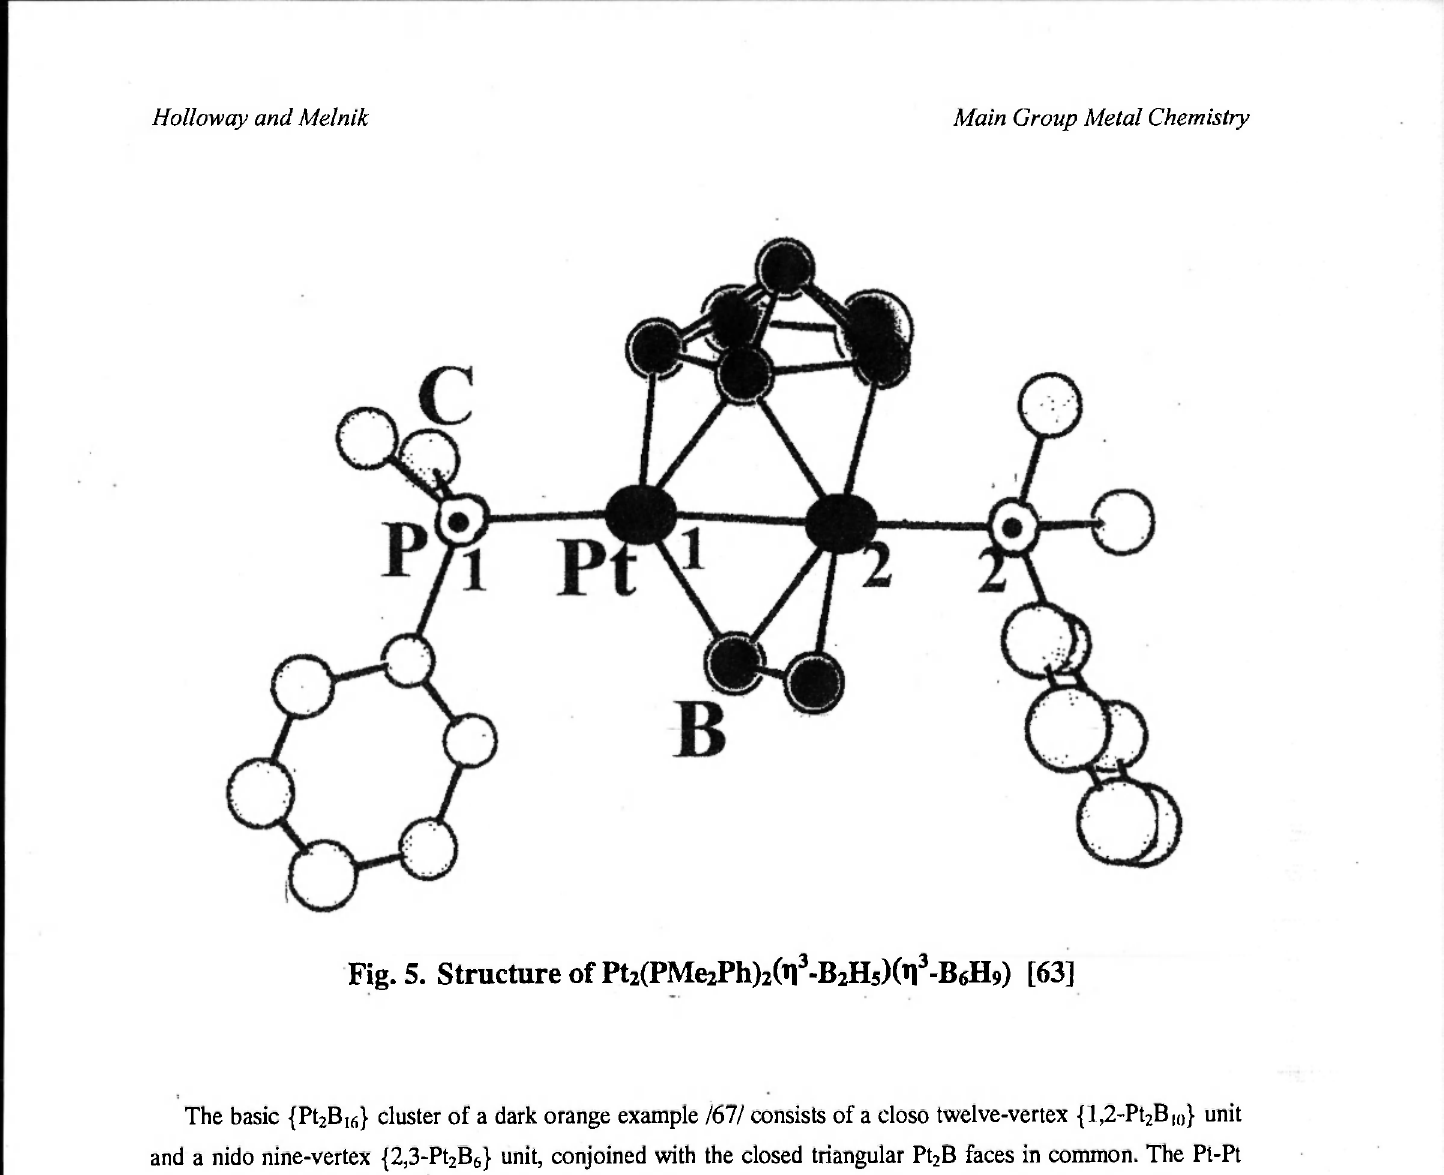
Fig. 5. S t r u c t u re of Pt 2 (PMe2Ph)2(n 3 -B2H5)(n 3 -B 6 H9)